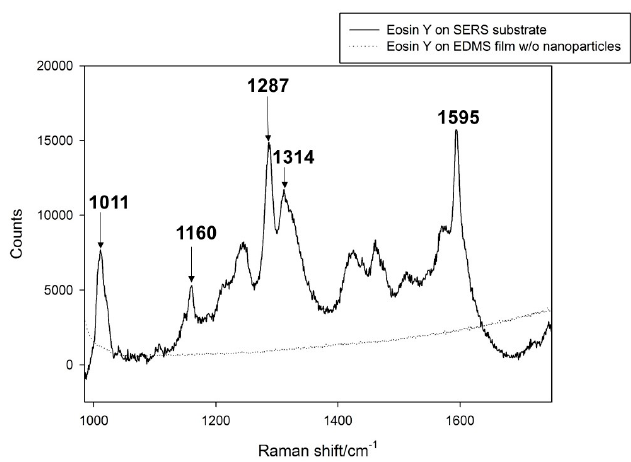
Figure 4. Raman spectra of Eosin Y (1 mM) adsorbed on epoxy film containing fractal aggregates of Au nanoparticles Eosin Y (1 M) on epoxy film without nanoparticles. The same acquisition conditions were used to acquire both spectra.